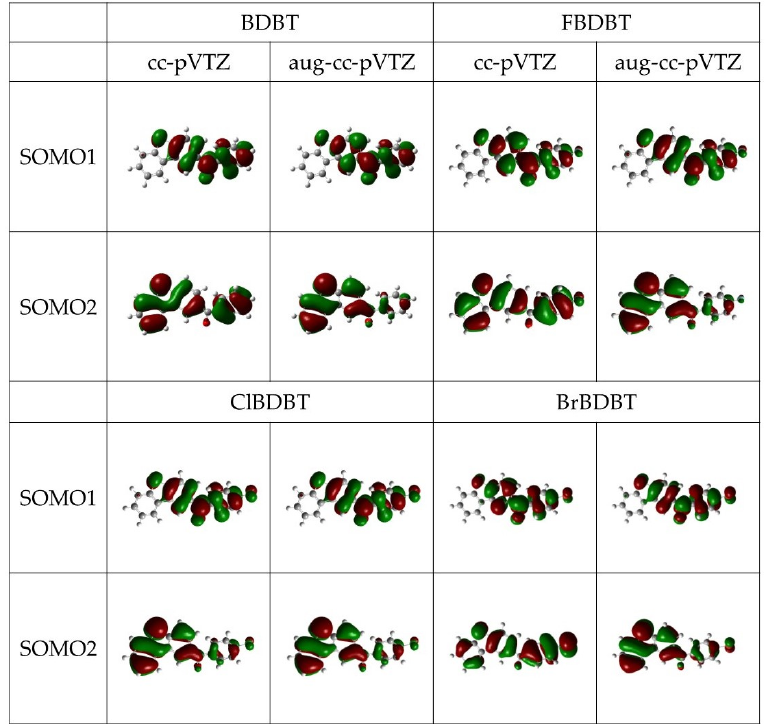
Figure 3. Molecular orbital diagrams of the SOMO1 and the SOMO2 that were obtained by choosing aug-cc-pVDZ and aug-cc-pVTZ for the BDBT, FBDBT, ClBDBT and BrBDBT aug-cc-pVDZ and aug-cc-pVTZ for the BDBT, FBDBT, ClBDBT and BrBDBT calculations.